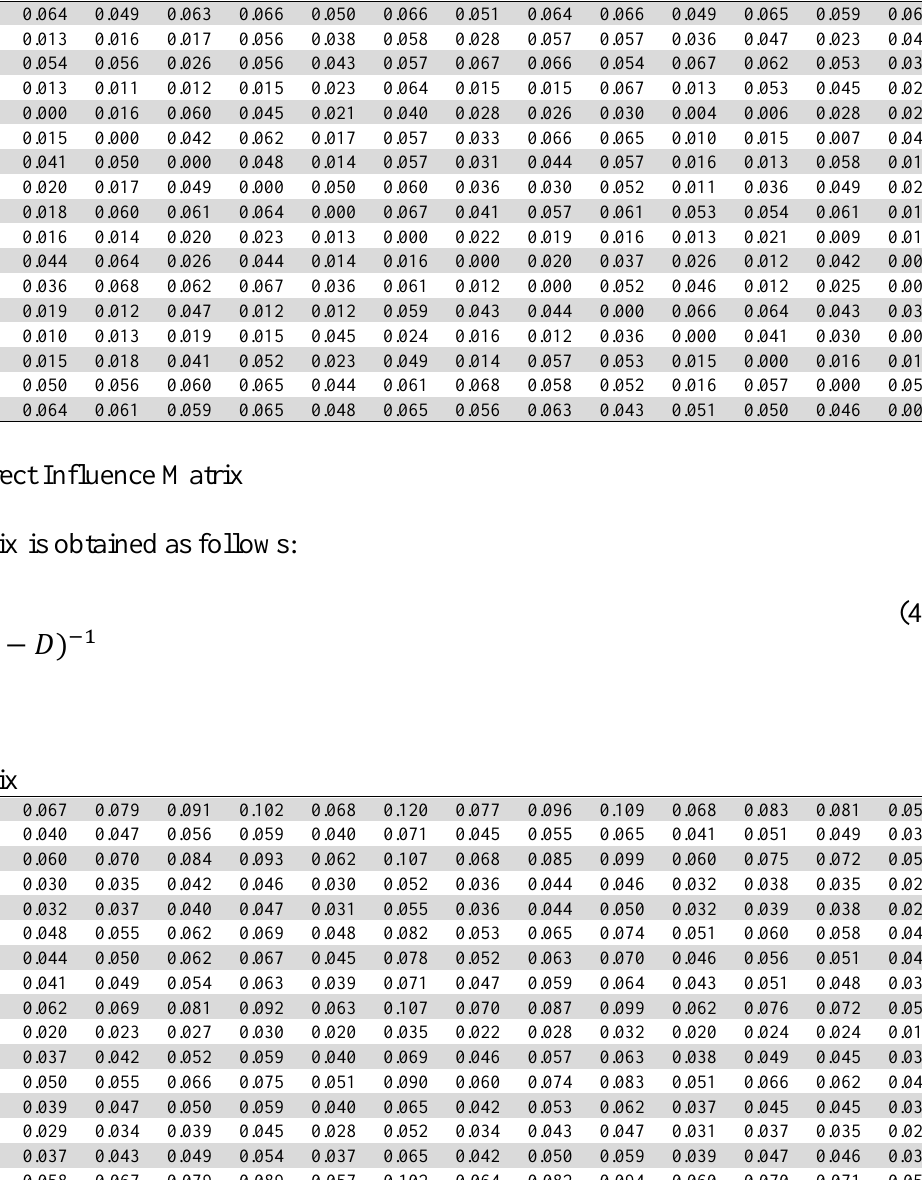
Normalized initial direct-relation matrix (matrix